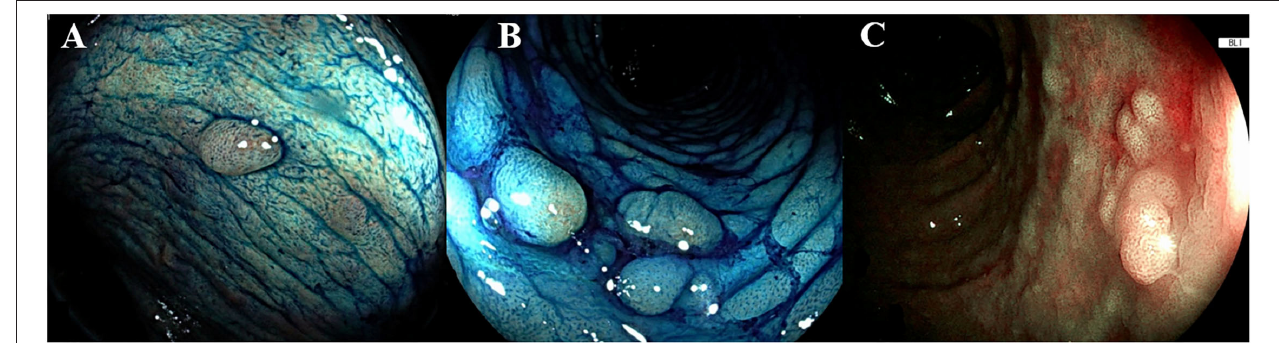
FIGURE 1 | Endoscopic appearance of dye-chromoendoscopy and virtual chromoendoscopy. (A,B) The dye is segmentally applied to the colon every 20 to 30cm with rotational movements of the endoscope, after spraying the dye, once the excess liquid has been suctioned, the mucosa is carefully examined. The colic mucosa presents a regular pattern, the presence of inflammatory pseudo-polyps is enhanced (pit pattern Kudo I-II). (C) A sporadic flat lesion with adenomatous appearance (pit pattern Kudo IIIS) in a UC patient, characterized through the blue laser image (BLI, Fujifilm, Japan). According to Kudo classification type I pits appear roundish; type II pits appear as stellar or papillary; type III-s pits are small roundish, tubular pits and type III-L are larger roundish and tubular; type IV pits appear as branch-like or gyrus-like while type V pits are non-structured. The normal mucosa, hyperplastic lesions and inflammatory polyps are comprehended in type I and II, whereas the pit pattern of the classes III-V is considered